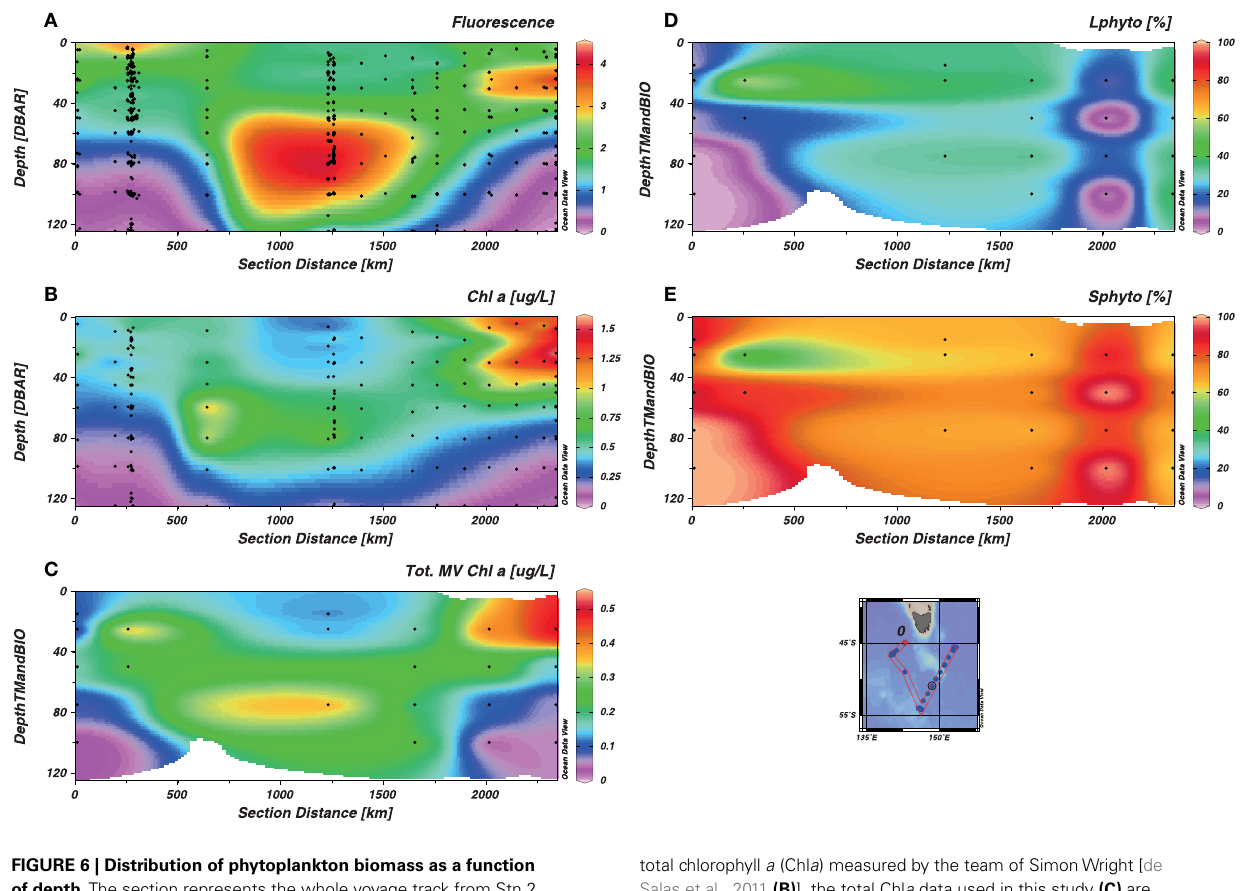
total chlorophyll a (Chl a ) measured by the team of SimonWright [de Salas et al., 2011 (B) ], the total Chl a data used in this study (C) are shown. In addition, the relative size distribution between large [L-phyto, > 10 µ m (D) ] and small phytoplankton [S-phyto, 0.8–10 µ m, (E)] are